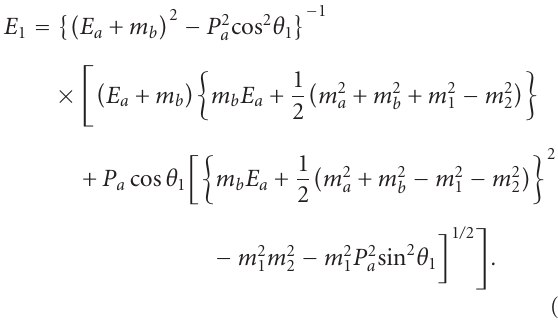
Figure 2: Comparison of relativistic and classical approach of energy-angle dependences of D-T neutron